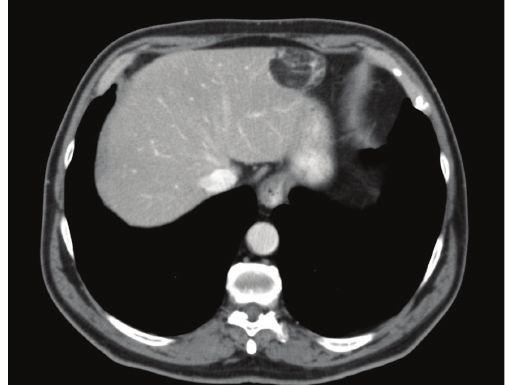
Figure 2: Trocar